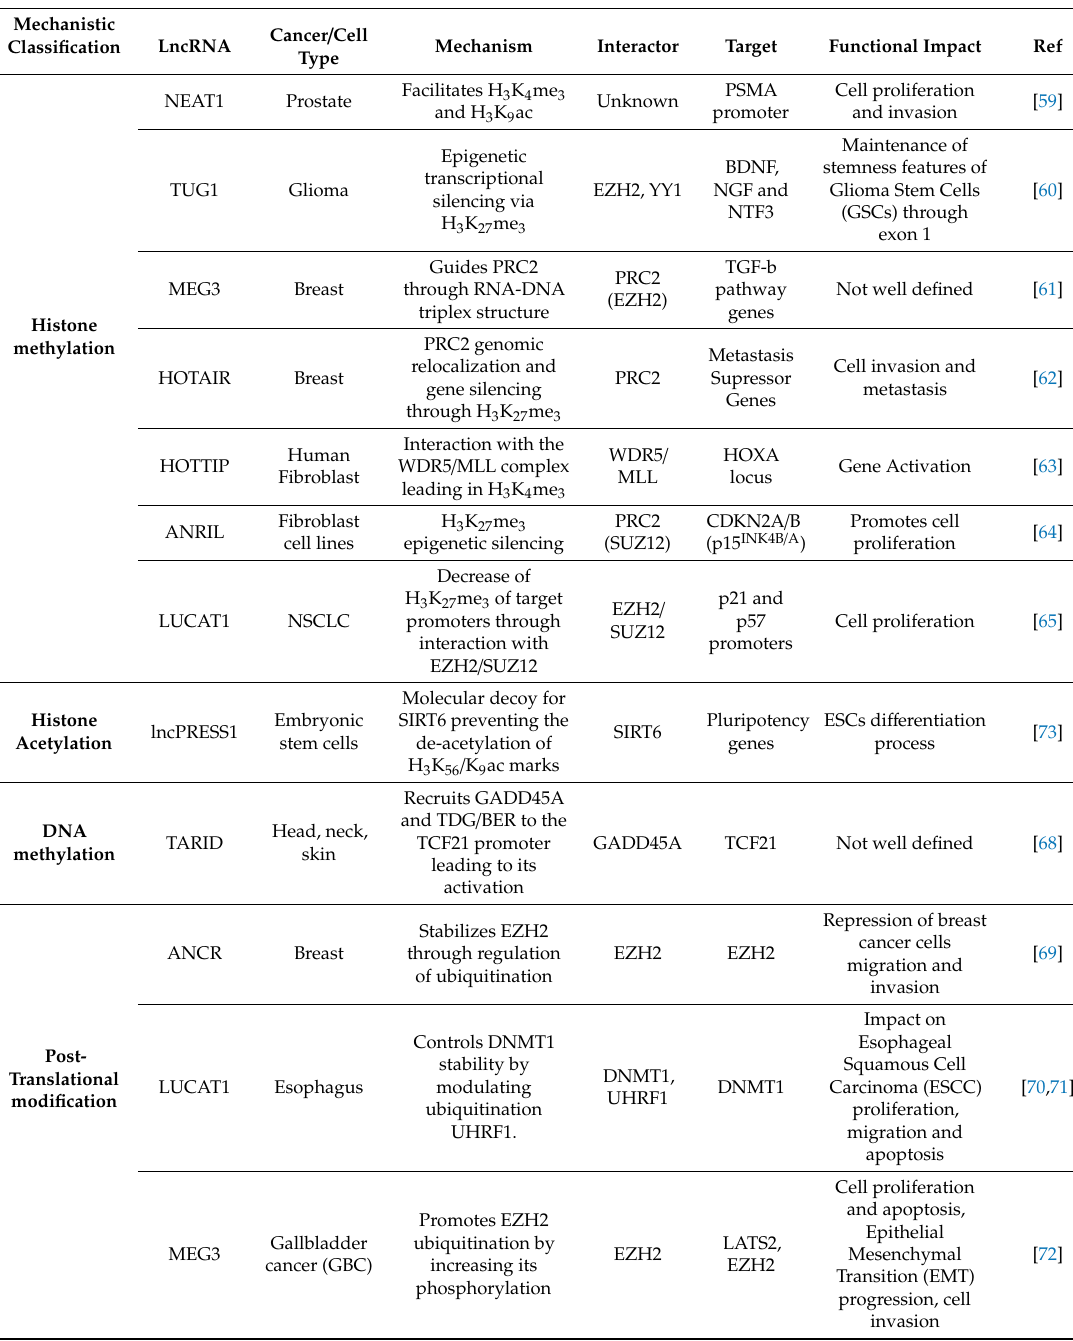
Table 1. Examples of mechanisms through which lncRNAs are involved in cancer chromatin regulation